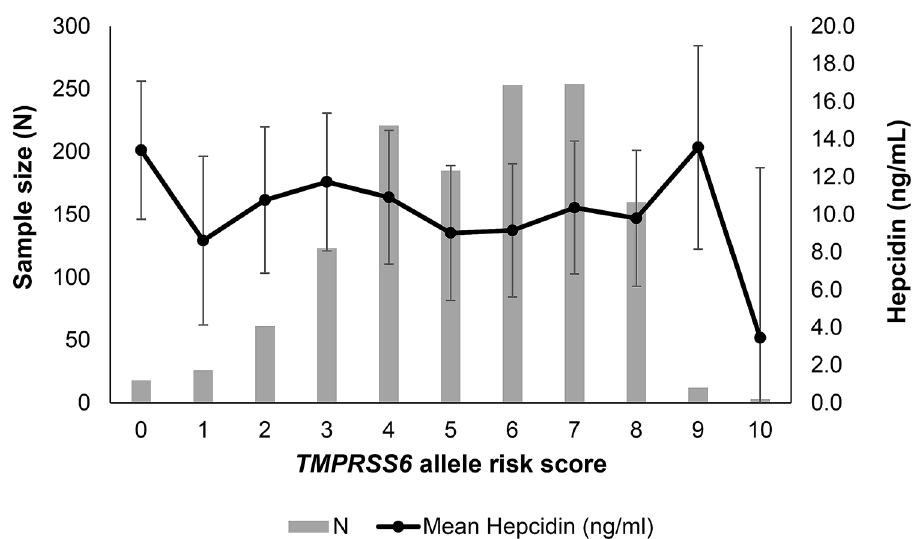
Figure 3. Influence of TMPRSS6 allele risk score on plasma hepcidin. Error bars = standard errors